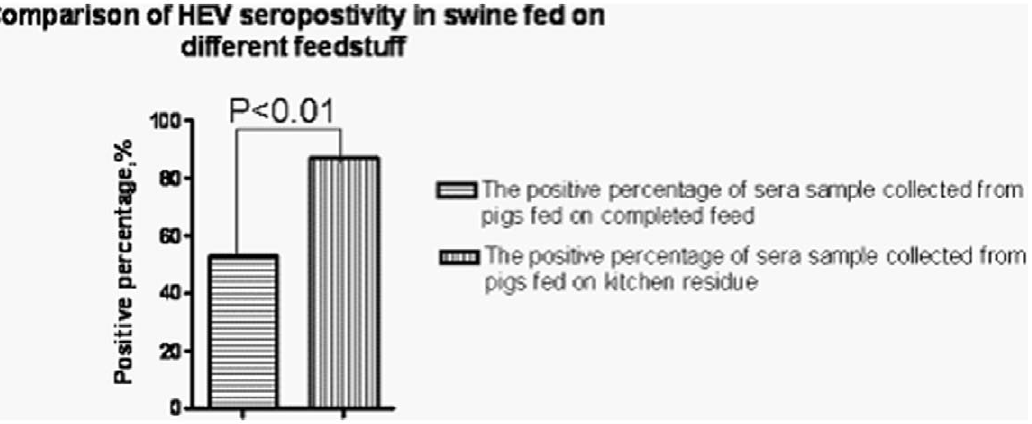
Figure 1. Comparison of HEV seropositivity in swine fed on different feedstuff. The percentage of positive serum samples from pigs fed on kitchen residue was clearly higher than that from those fed on complete